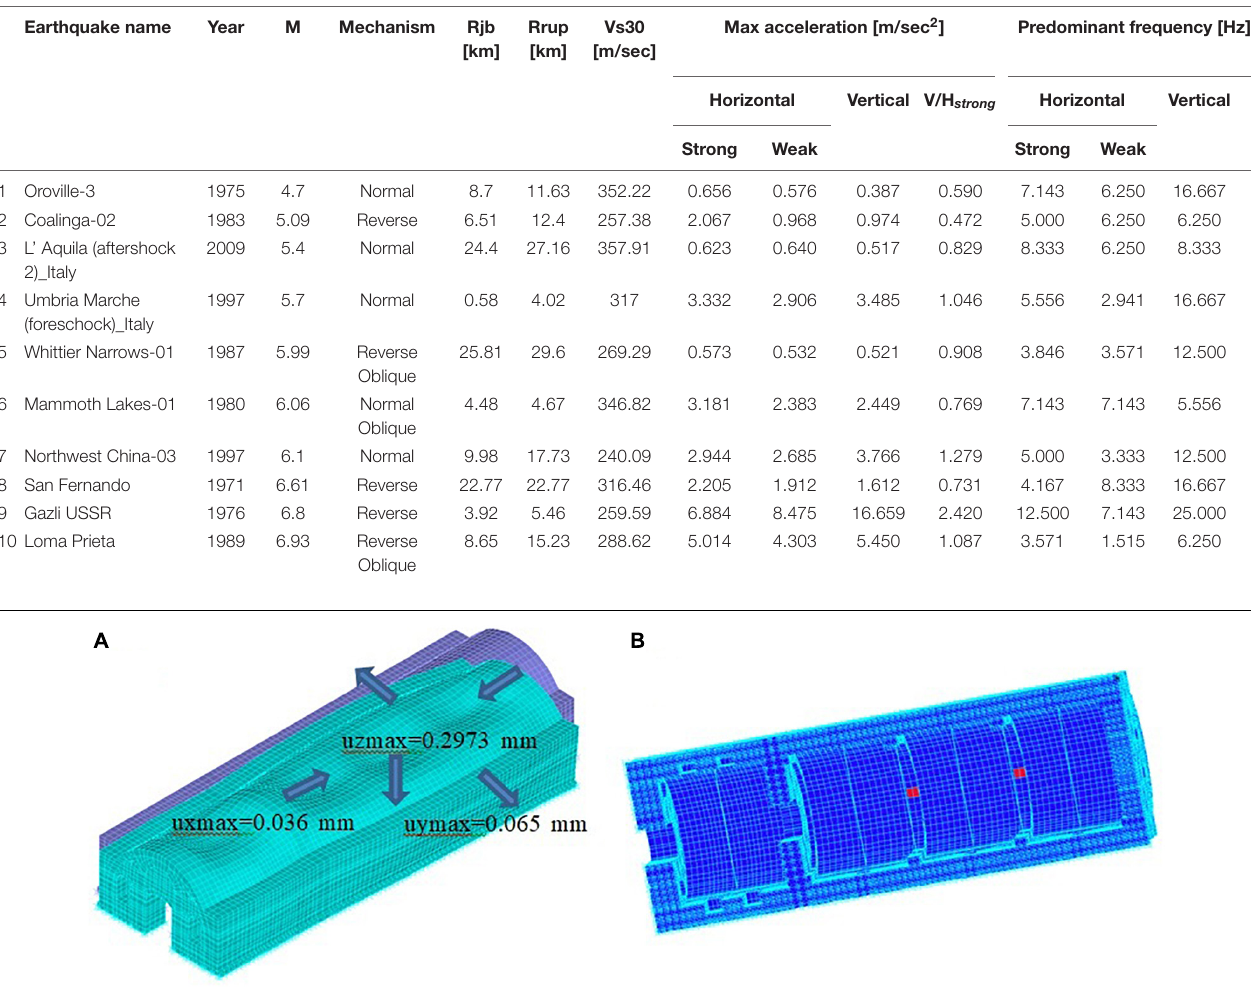
TABLE 1 | Ground motion records characteristics.